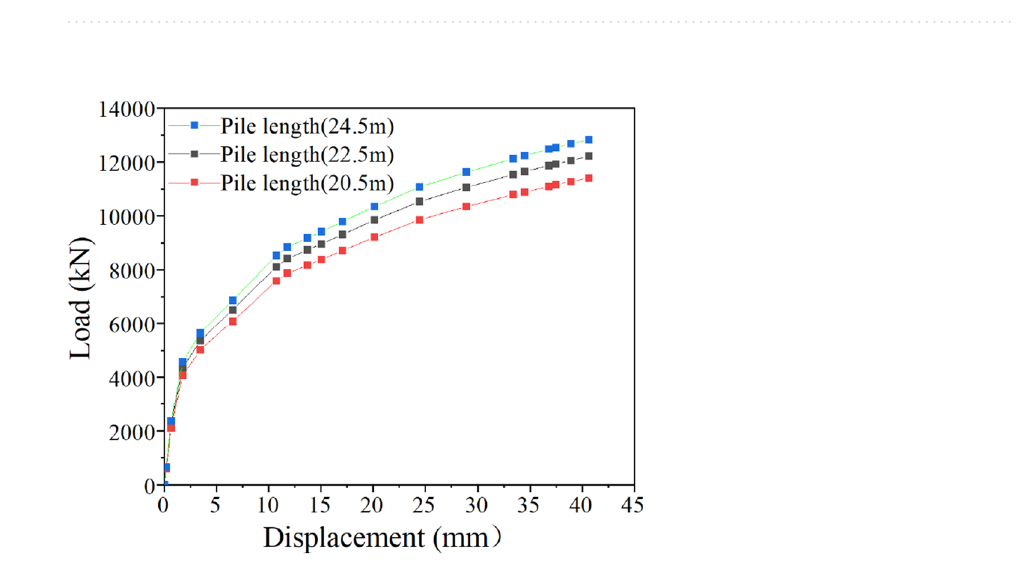
Figure 14. Influence of the pile